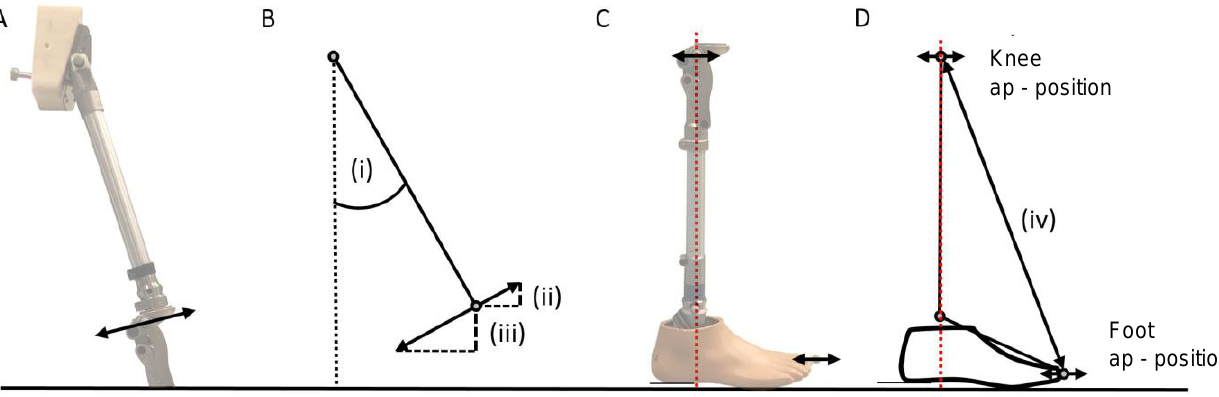
Figure 5: Effect of a-p positioning of the knee and foot components (A) experimental set up, (B) schematic diagram of the effect of a-p positioning of the knee, (i) hip flexion angle, (ii) gain of ground clearance, (iii) loss of ground clearance, (C) prosthetic alignment, (D) schematic diagram of shortening and elongation of the shank, respectively, (iv) depending on the position of the knee and